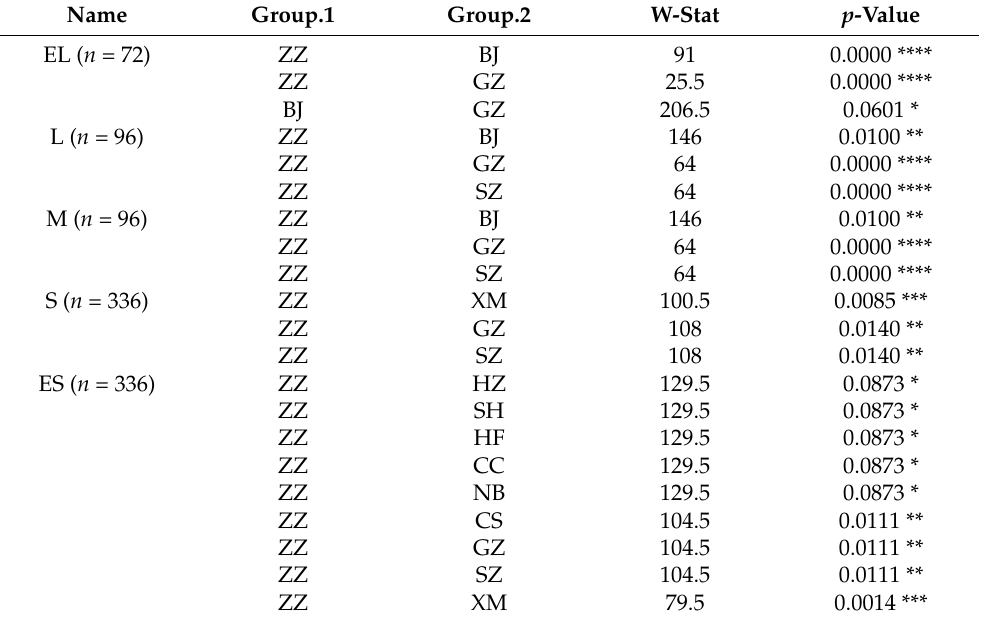
Table 5. The differences between ZZ and wholesale markets and between the wholesale markets in the ZZ group.